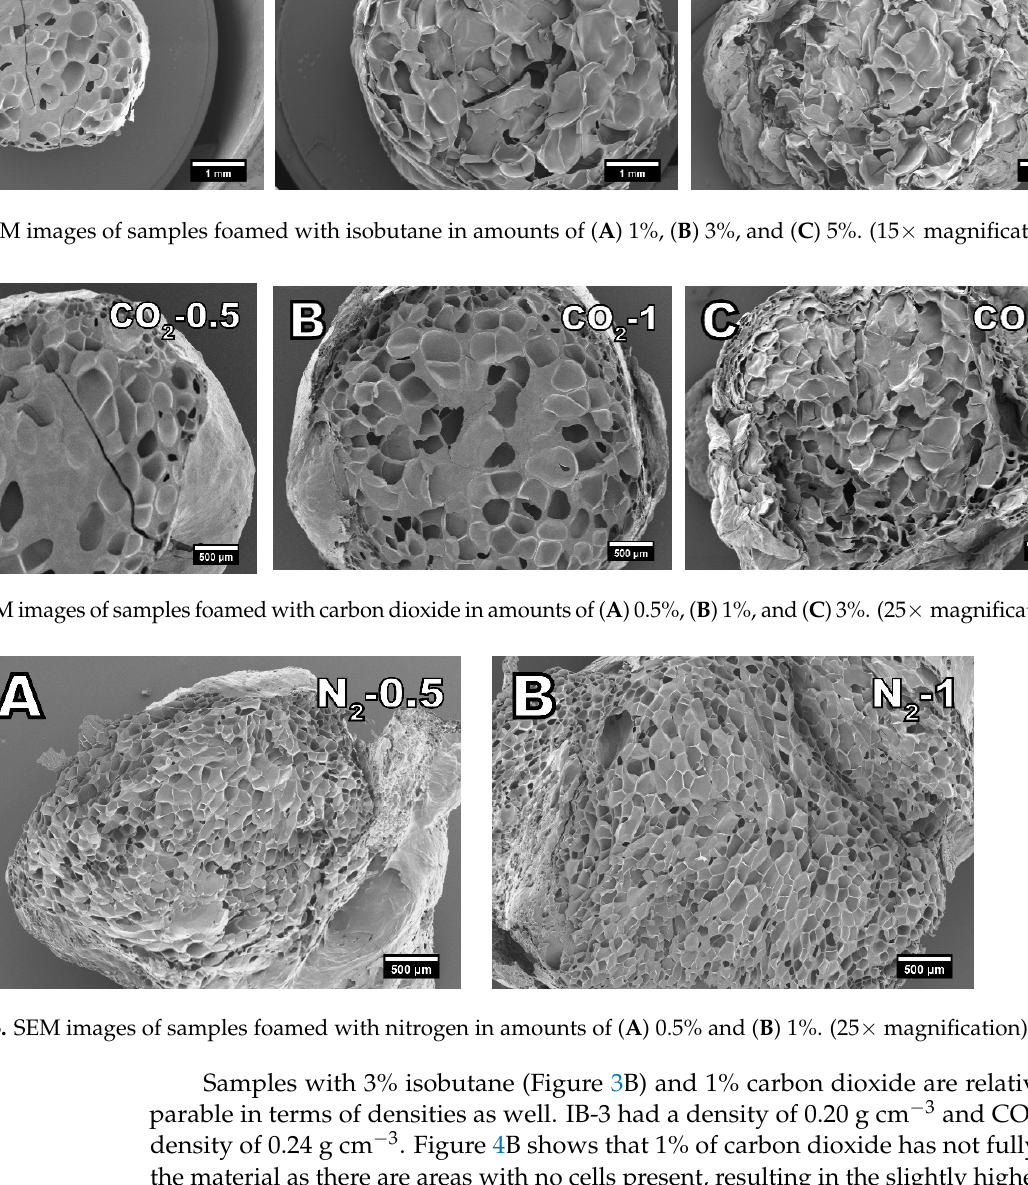
Figure 2. Side profiles of produced cellulose palmitate foams: ( A ) IB-1, ( B ) IB-3, ( C ) IB-5, ( D ) CO 2 -0.5, ( E ) CO 2 -1, ( F ) CO 2 - 3, ( G ) N 2 -0,5, and ( H ) N 2 -1. The scale is approximate.